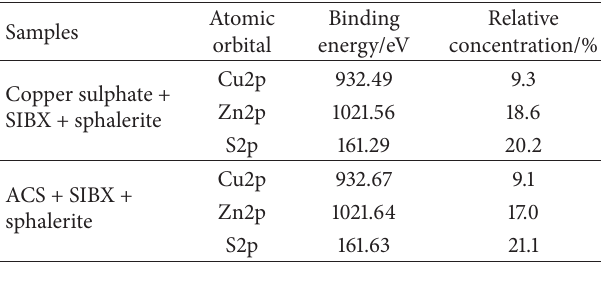
Table 2: Binding energy and relative concentration of elements before and after reactions.